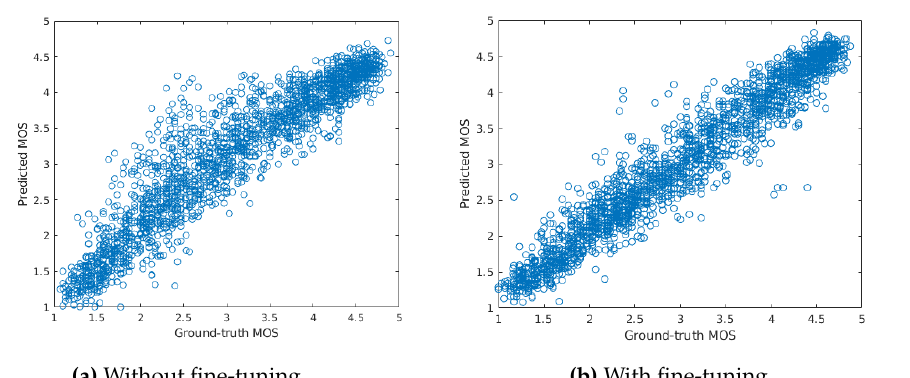
Figure 5. Scatter plots showing the ground-truth MOS values against the predicted MOS values on KADID-10k [34] test set.